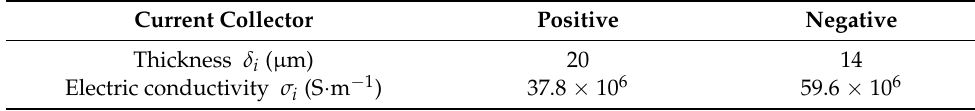
Table 4. Material parameters of the current collectors [32].